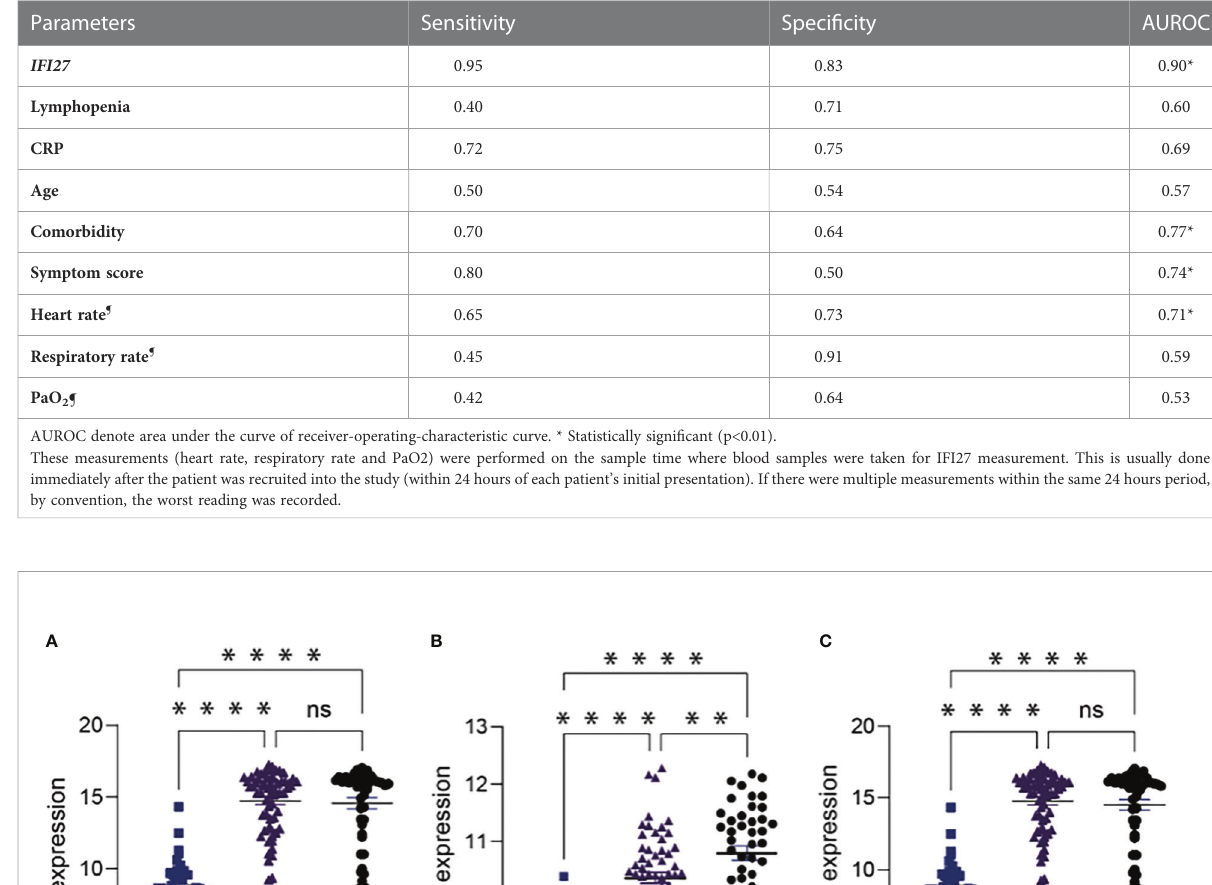
TABLE 2 Performance of blood IFI27 gene-expression in predicting composite outcome in Cohort 7. Parameters